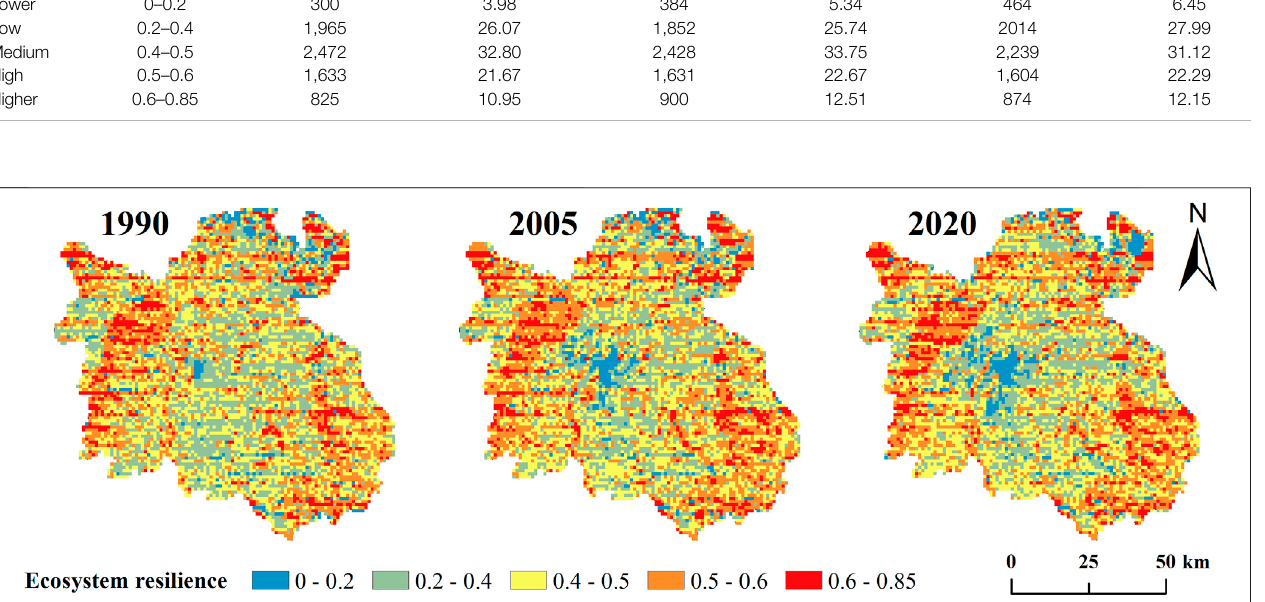
Frontiers in Earth Science |